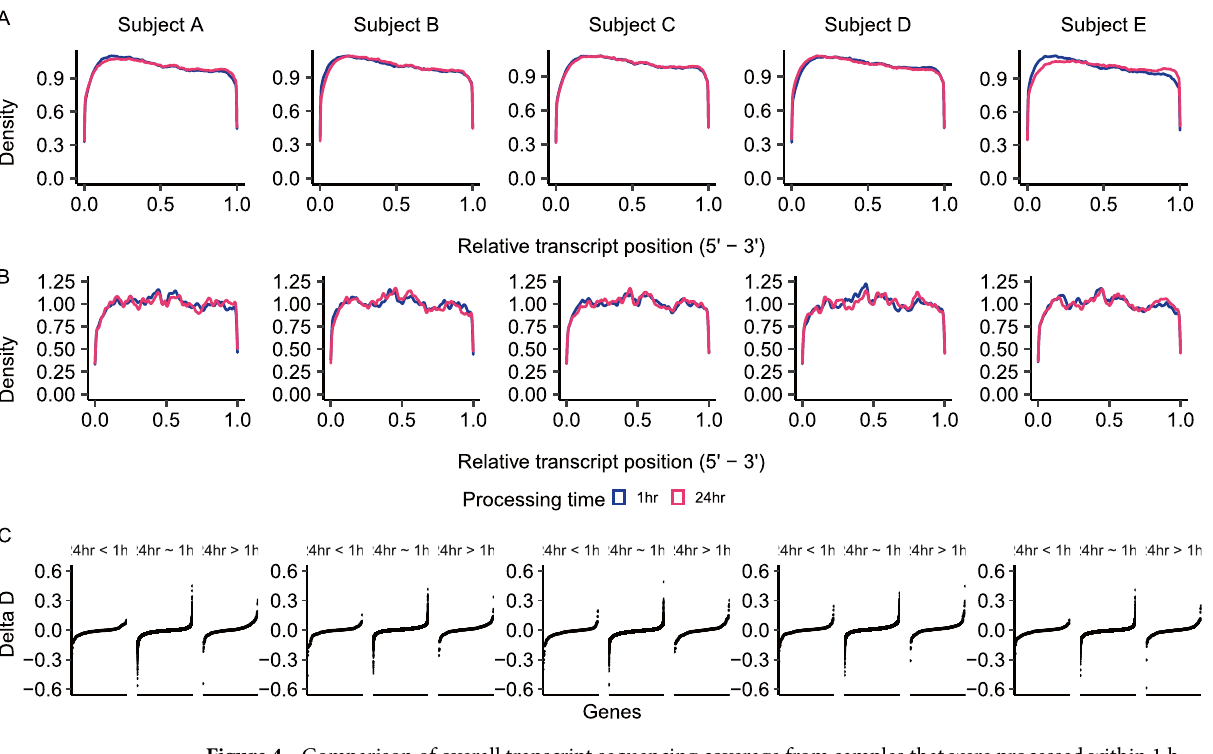
Figure 4. Comparison of overall transcript sequencing coverage from samples that were processed within 1 h and 24 h after blood collection. ( A ) Genes with no change in transcript abundance 24 h of storage at 4 °C. ( B ) Genes with lower transcript abundance after 24 h of storage at 4 °C. ( C ) Plots of the Delta D-statistic for all genes separated by their results of the contrast ‘24 h vs 1 h’.